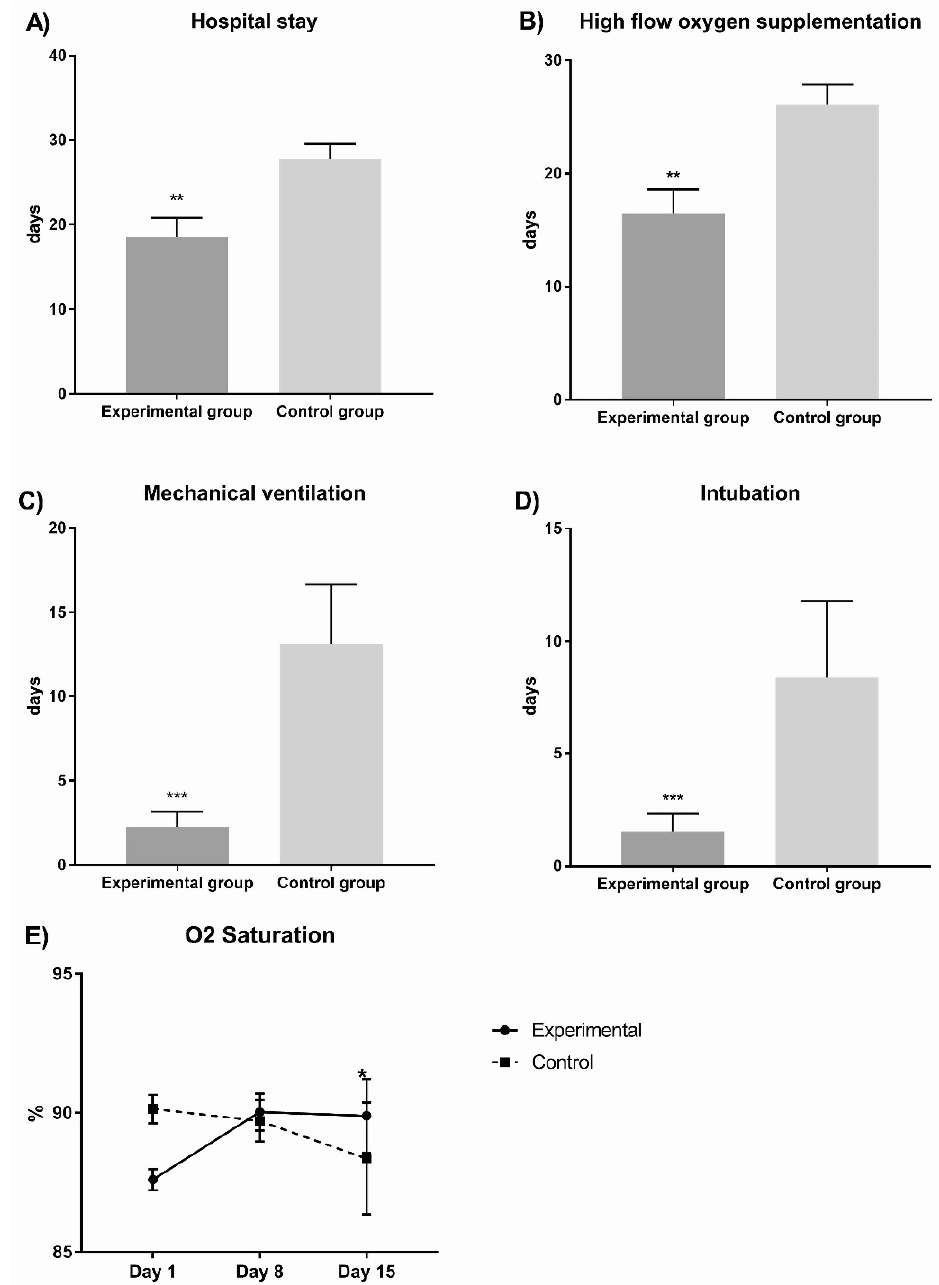
Figure 1. Comparisons between experimental and control groups of principal outcomes evaluated in COVID-19 patients. In ( A ) we observed the hospital stay; in ( B ) we observed the high flow oxygen supplementation; in ( C ) we observed the mechanical ventilation; in ( D ) we observed the intubation and in ( E ) we observed the oxygen saturation during hospital stay days comparing both experimental vs. control group. The experimental group presented significantly fewer hospital stay days ( p = 0.01), high-flow-oxygen-supplementation days ( p = 0.001), mechanical-ventilation days ( p = 0.003), and intubated days ( p = 0.01); in contrast, oxygen saturation significantly increased ( p = 0.01 * p < 0.05, ** p < 0.01, *** p < 0.001.